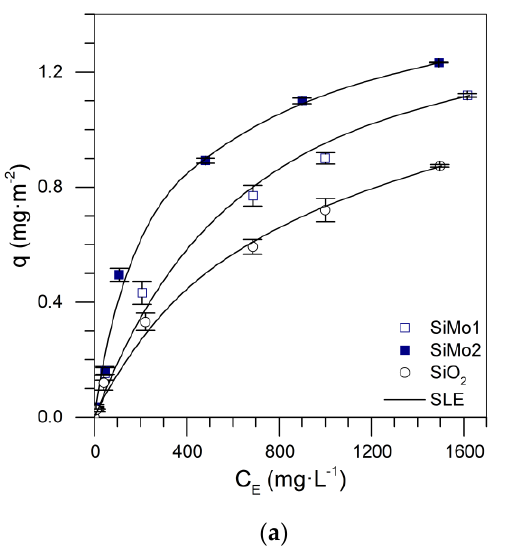
Table 5. Coefficients of the Special Cubic Model for mixture design with Si-Fe-Mo.